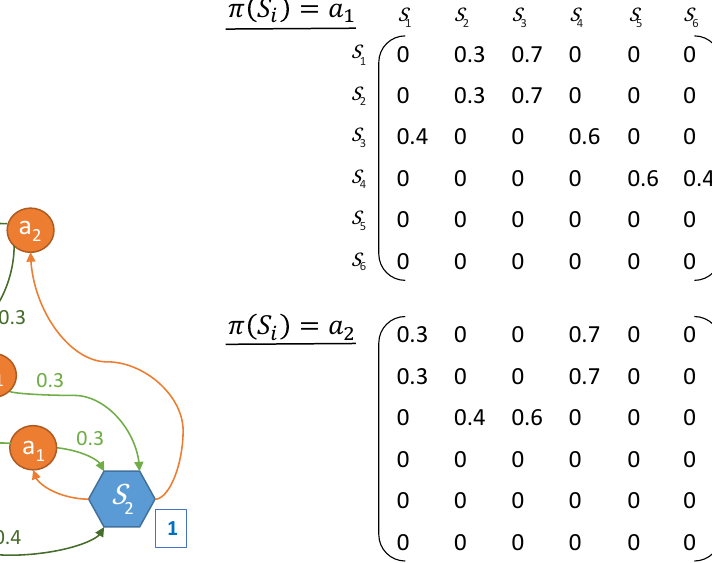
Figure 1. An example of a Markov decision process ( left ). The blue hexagons represent the states, with their rewards indicated in blue boxes next to the state. Orange circles indicate the two actions that can be taken in each state. Subject to the action, the transition probabilities are indicated with green arrows and the value displayed next to the arrow. Transition probabilities following action a 1 are shown in light green, while transition probabilities following action a 2 are shown in dark green. The policies “choose action a 1 in all states” (upper) and “choose action a 2 in all states” (lower) are presented by their transition matrices ( right